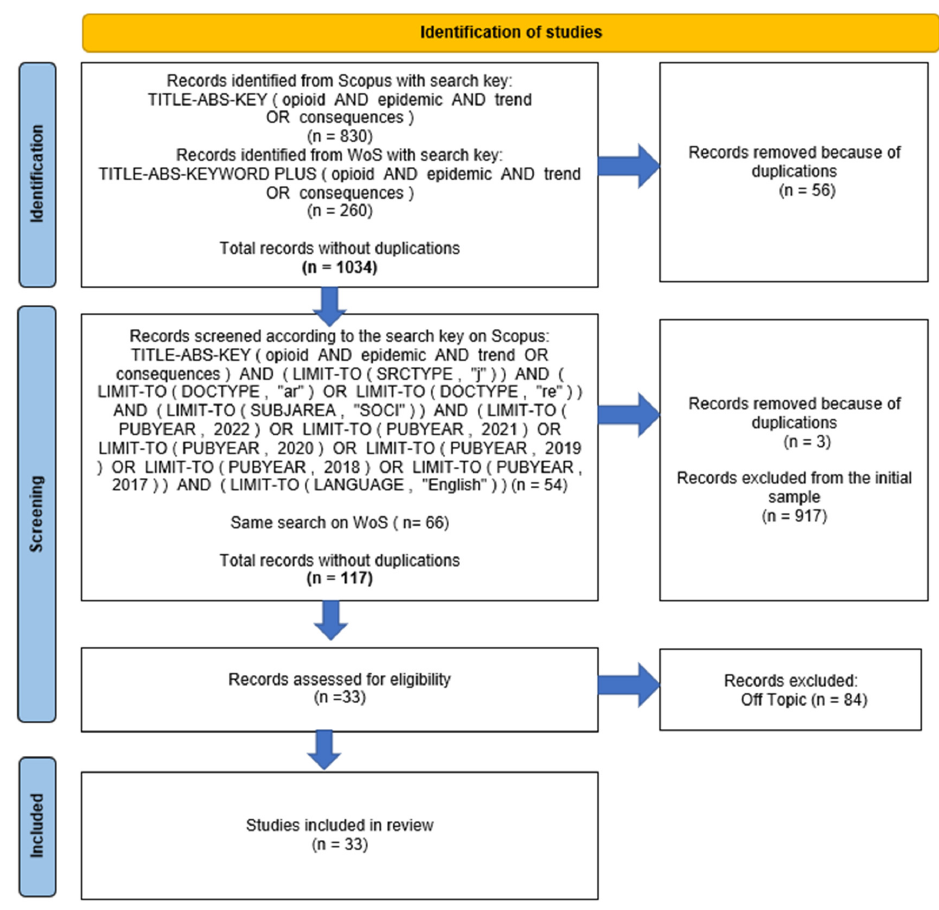
Figure 1. Process of article selection using the PRISMA methodology. Source: Authors’ elaboration following Page et al. [30].